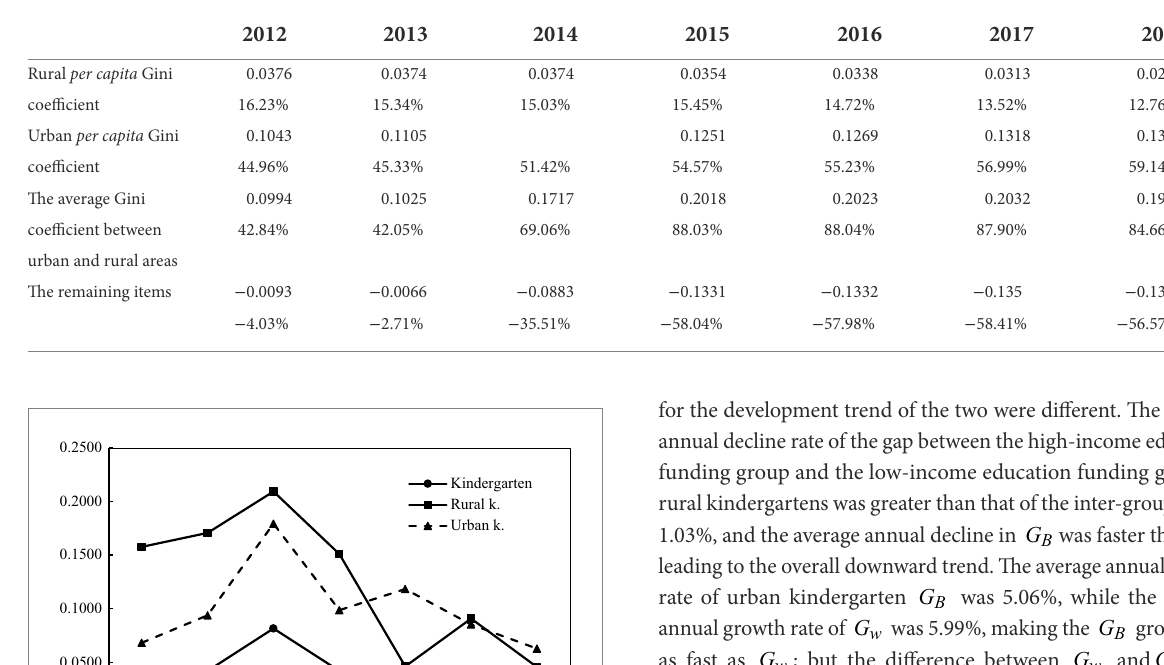
TABLE 10 Decomposition of the overall gap in different areas of villages and towns.